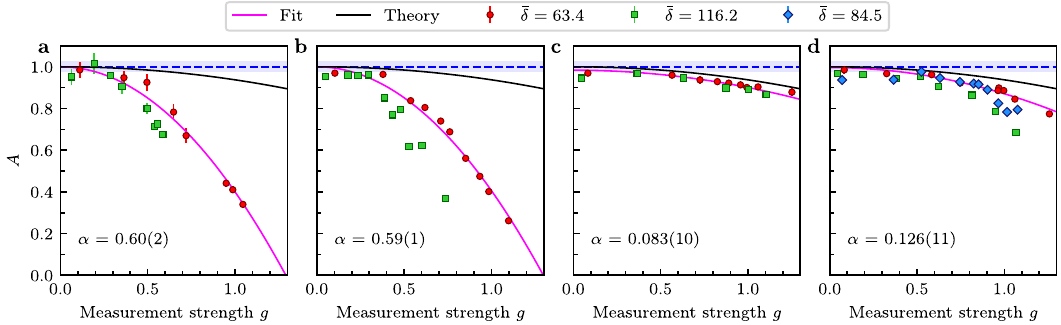
Fig. 4 Ramsey interferometer contrast A dependence on the measurement strength g for different schemes. a In situ Ramsey interferometry measurements. b In situ Ramsey interferometry with spin-echo measurements. c In situ Pulse-evolve-pulse with spin-echo Ramsey interferometry measurements. d Pulse-evolve-pulse with spin-echo sequence after 2 ms TOF measurements. The horizontal blue lines show the RI contrast observed without the measurement pulse with the shaded regions indicating the ±1 σ statistical uncertainty range. The black curves plot the prediction of our photodetection model. The pink curves depict a fi t of the (cid:2) δ ¼ 63 : 4 data to A = A 0 − α g 2 with each best- fi t alpha value quoted on the respective fi gure. COMMUNICATIONS PHYSICS| (2023) 6:66